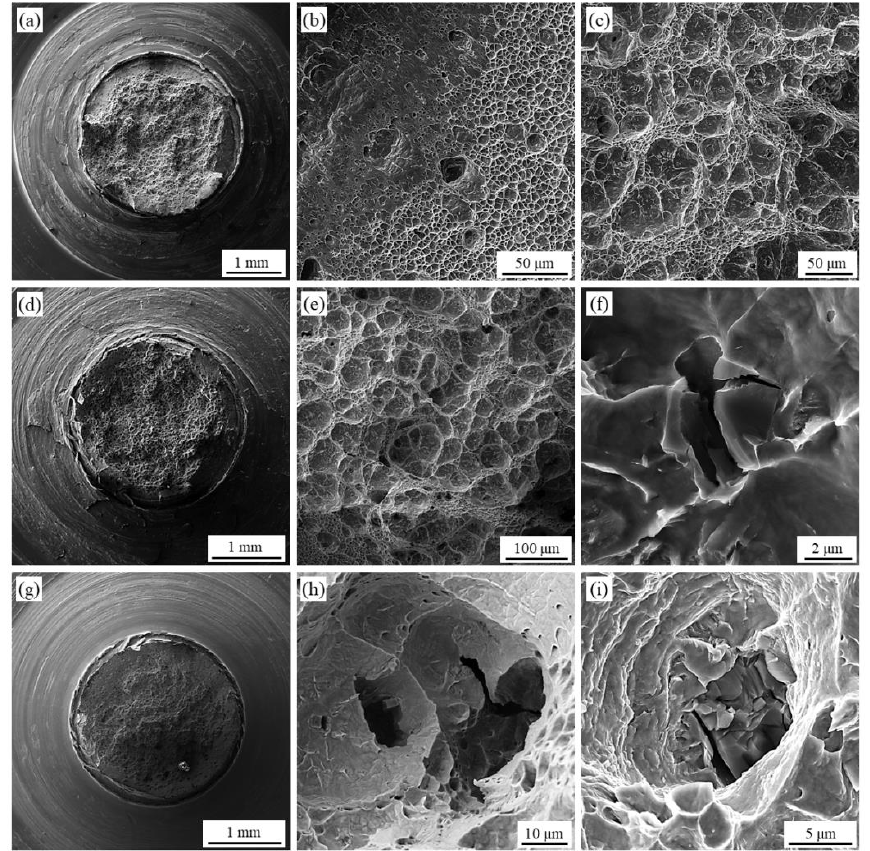
Figure 6. Micrographs of UNS S32205 reinforcement after slow strain rate test (SSRT) immersed in SCPS: 0 wt.% Cl – ( a ) rupture surface × 50 ( b ) microvoids and coalescence of dimples × 1300, ( c ) ductile overload areas × 1000; 4 wt.% Cl – ( d ) rupture surface × 50, ( e ) ductile overload area × 600, ( f ) brittle fracture inside the ferrite cleavage facets × 22,800 ; 8 wt.% Cl – ( g ) rupture surface × 50, ( h ) cracks inside the ferrite cleavage facets × 4500, and ( i ) crack nucleation due to inclusions ×